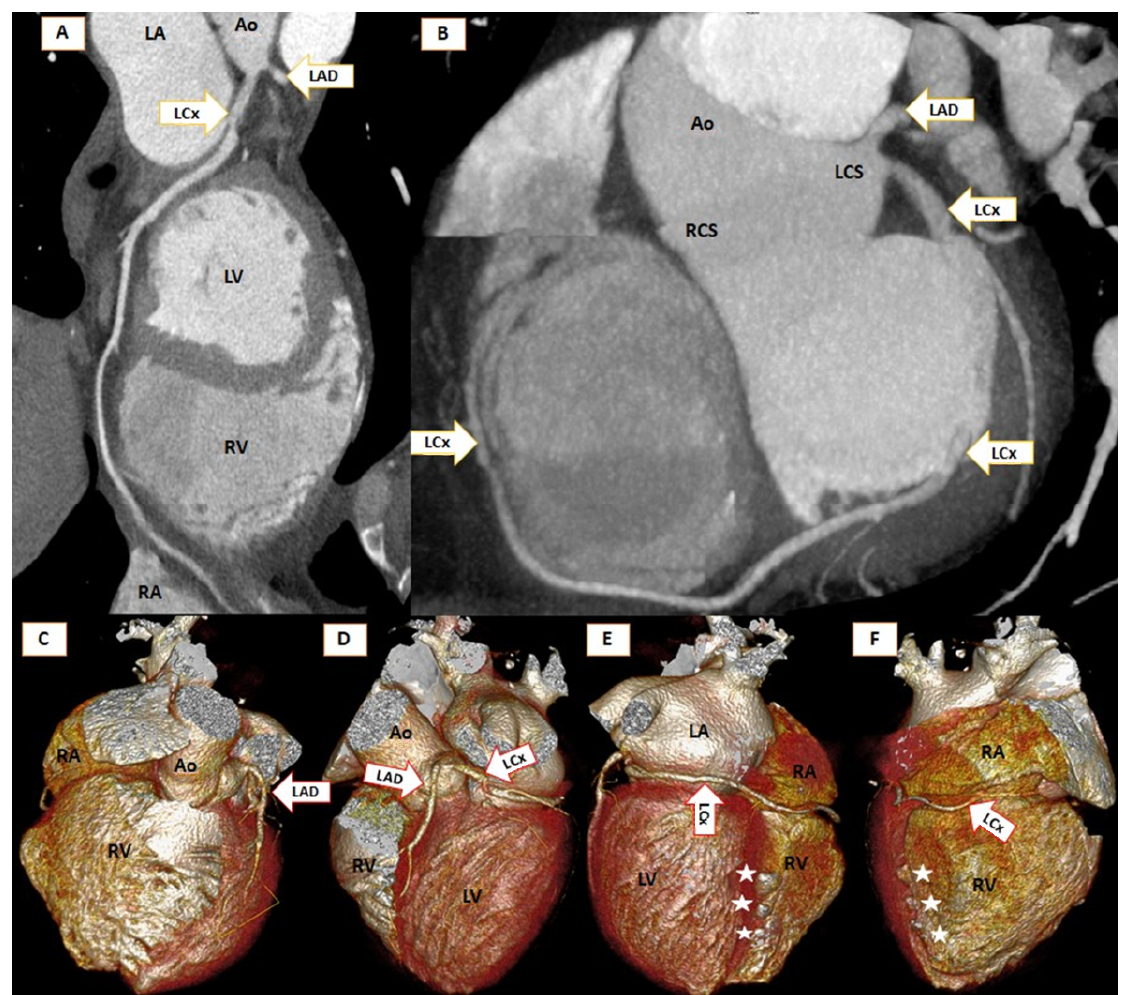
Figure 1. Panel ( A ): Curved multiplanar reconstruction images of the left circumflex artery (LCx) demonstrate its course around the atrioventricular groove. The left main coronary artery was also absent, with both left anterior descending (LAD) and LCx arising from the left coronary sinus with a “double-barrel” appearance. Regardless of the branches involved (right coronary artery, LAD, or LCx), the four classical coronary course variants are classified as normal, pre-pulmonary, interaorto-pulmonary, and retroaortic [1–3]. Panel ( B ): Maximum intensity projection of the left circumflex coronary artery (LCx) course. LCx emerges from the left coronary sinus and has a 3 mm diameter. It travels in the left atrioventricular (AV) groove, continues in the AV groove of the inferior aspect of the heart, and then ascends in the right AV groove to the right auricular ostium. Its ramifications include two marginal branches, a posterolateral branch, a thin posterior descending artery, and, from the right AV groove, an acute marginal branch (AM) and a branch to the sinoatrial node. A note is made of the missing right coronary artery (RCA). Panels ( C – F ): The 3D virtual rendering technique (VRT) illustrates the absence of the right coronary artery arising from the right coronary sinus, the absence of the left main coronary artery, and the double-barrel appearance. LCx travels around the heart in the AV groove. Panels ( E , F ) visualize three diverticular dilatations on the inferior side of the right ventricle (RV; white stars). Such diverticular dilatations of the RV are rare and have variable natural history, requiring supportive treatment unless they are causing symptoms. LA: Left atrium, LV: Left ventricle, RV: Right ventricle, RA: Right atrium, LCS: Left coronary sinus, RCS: Right coronary sinus, Ao: Aorta, LAD: Left anterior descending coronary artery, LCx: Left circumflex coronary artery, Five-pointed star: Right ventricle